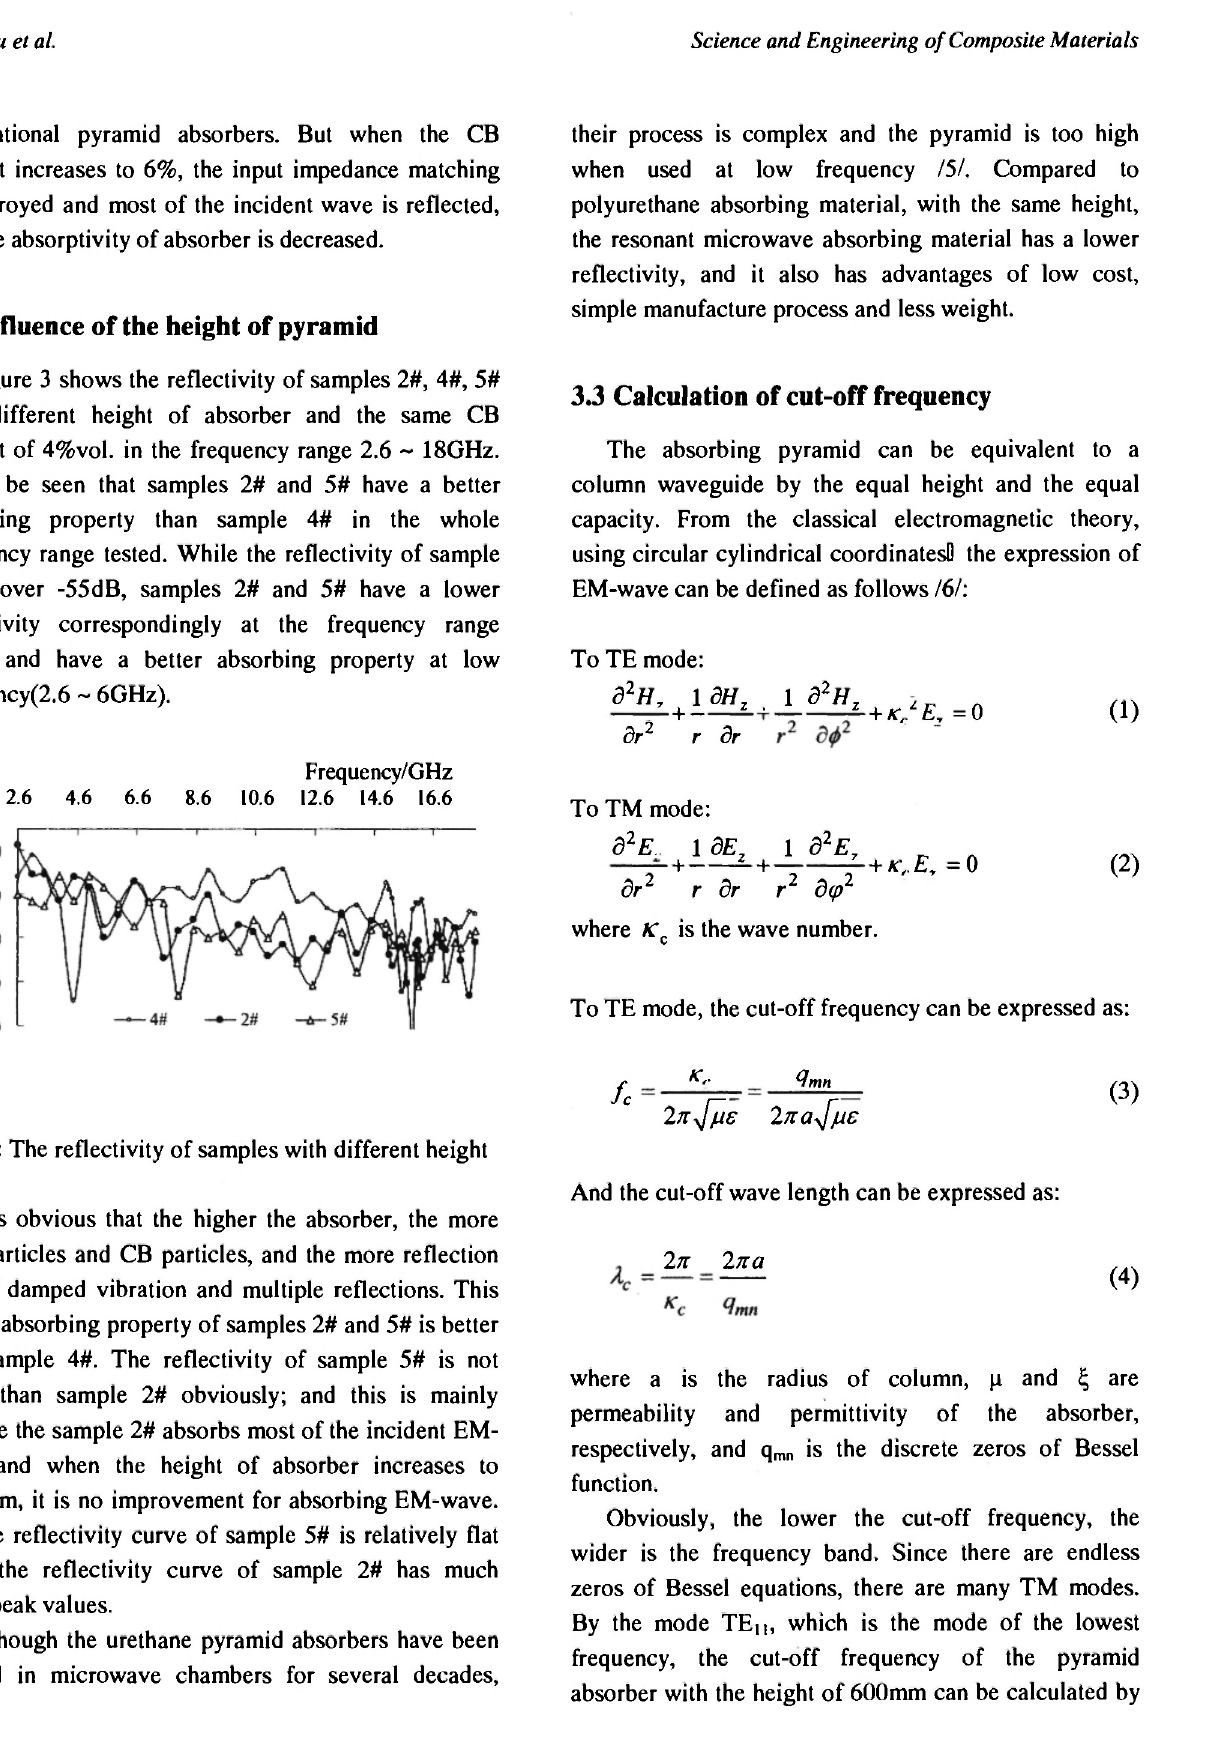
Fig.3: The reflectivity of samples with different height It is obvious that the higher the absorber, the more EPS particles and CB particles, and the more reflection loss of damped vibration and multiple reflections. This is why absorbing property of samples 2# and 5# is better than sample 4#. The reflectivity of sample 5# is not lower than sample 2# obviously; and this is mainly because the sample 2# absorbs most of the incident EM- wave and when the height of absorber increases to 1000mm, it is no improvement for absorbing EM-wave. But the reflectivity curve of sample 5# is relatively flat while the reflectivity curve of sample 2# has much sharp peak